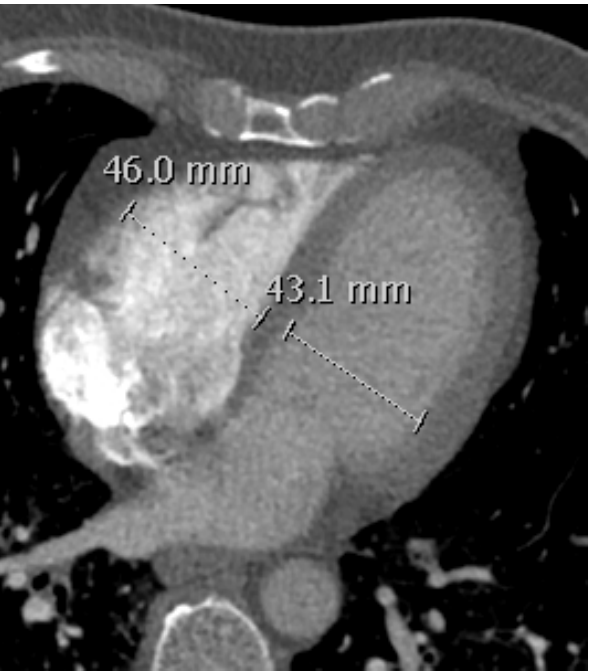
Figure 3. Measurement of right and left ventricle diameter using the axial method on a transverse CT angiography.